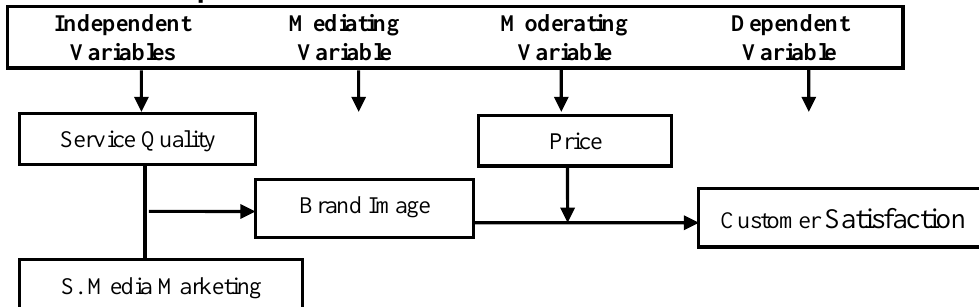
Figure.1. Conceptual